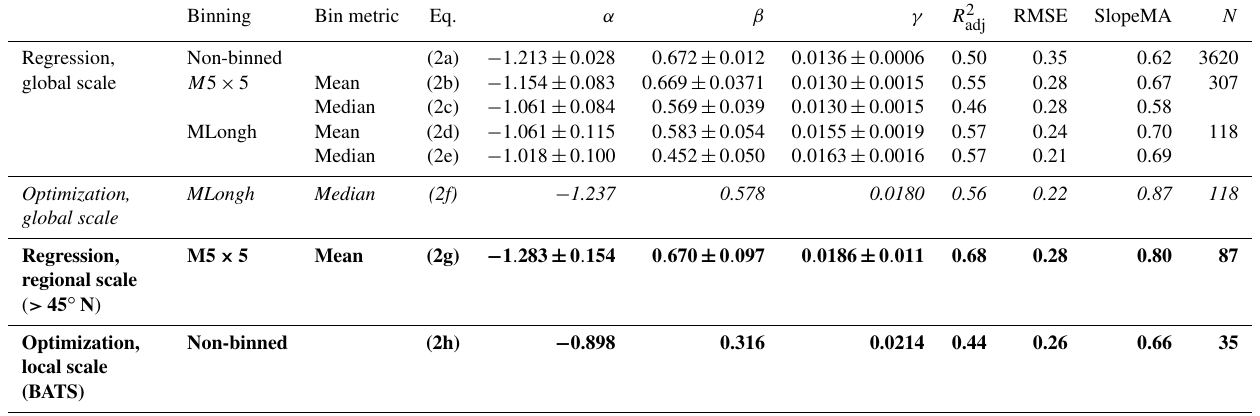
Table 2. Summary of fitted model coefficients and goodness-of-fit statistics. Different sets of coefficients were obtained by fitting the model and (2h) were derived using a different optimization procedure, applied to the global MLongh binned dataset and to the BATS station local dataset. The models implemented to calculate a global DMS climatology are denoted in italic, regional or local time series in